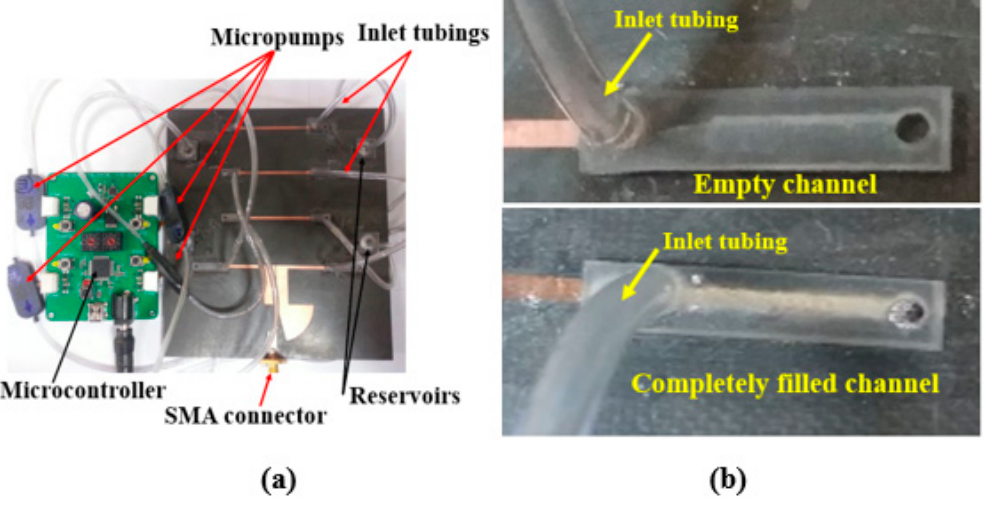
Figure 5. Pictures of ( a ) the fabricated prototype of the frequency-reconfigurable antenna and ( b ) magnification of empty, and completely filled channels. ( b ) magnification of empty, and completely filled